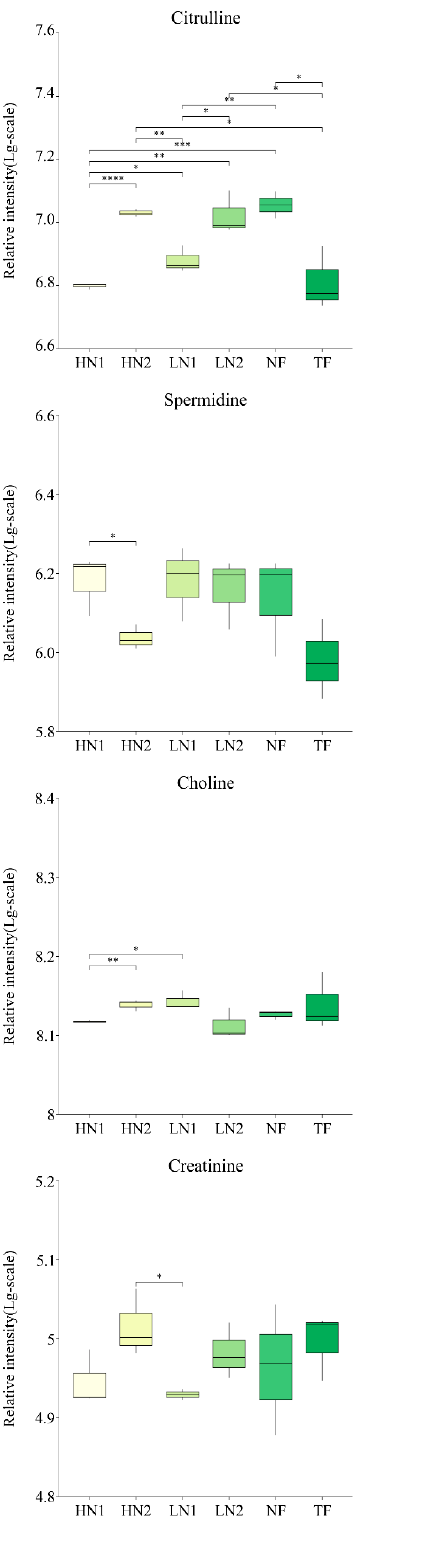
Figure 3. Changes of amino acids accumulation in tea leaves with different N supply. In total, 30 kinds of amino acid components were detected, and this figure shows only those with significant differences. The statistical approach used was a two-tailed t -test. Every group contains 3 tea leaf samples. ****, ***, **, * indicates a significant difference at p < 0.0001, p < 0.001, p < 0.01, and p < 0.05,